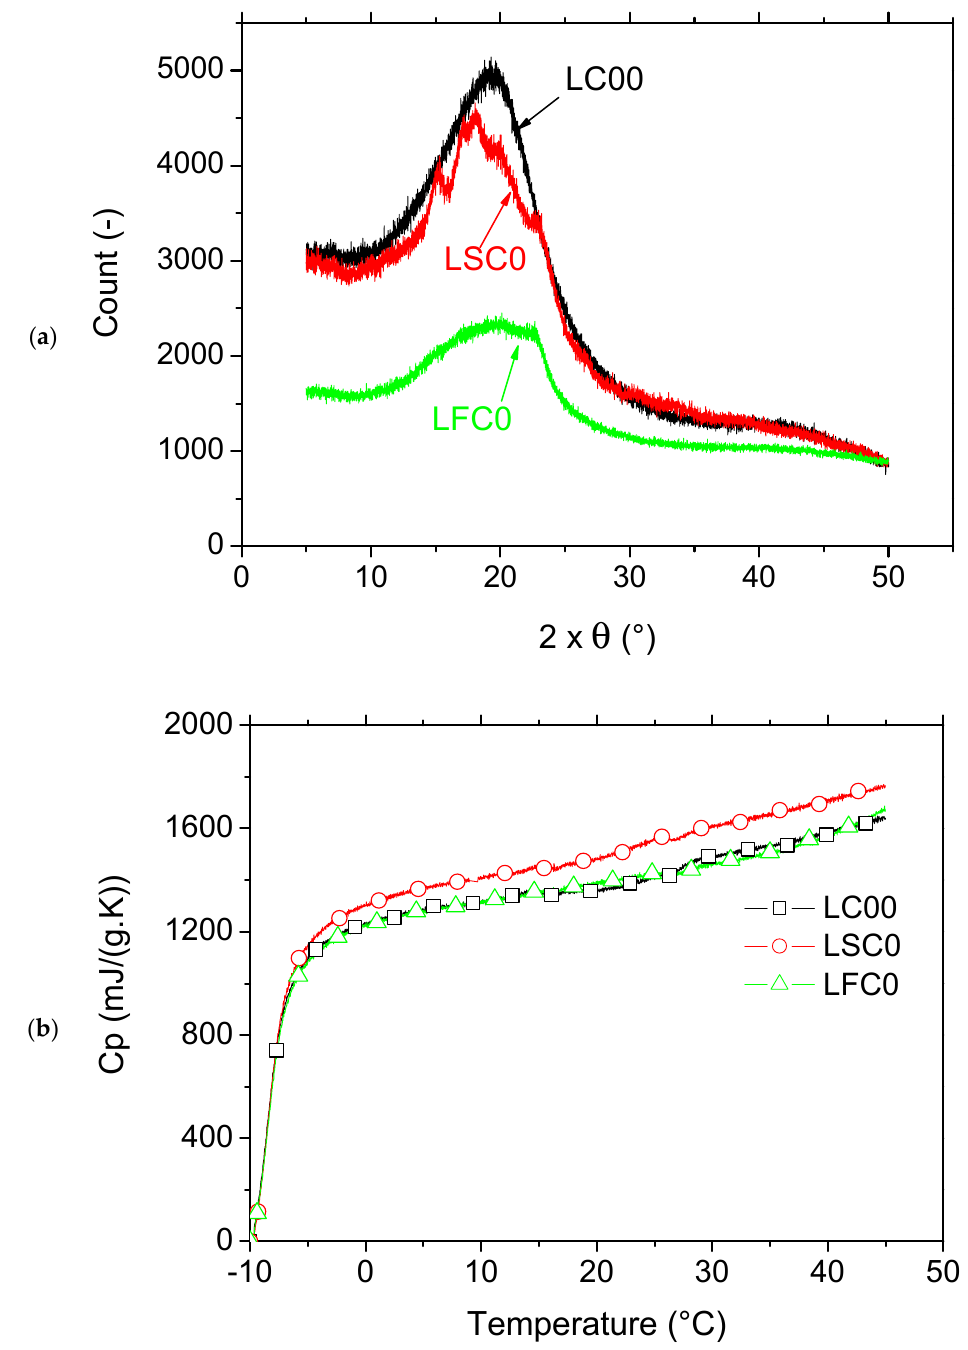
Figure 5. Comparison between genuine photosensitive and modified resins by starchy particles. ( a ) X-ray diffraction patterns, ( b ) specific heat capacity.